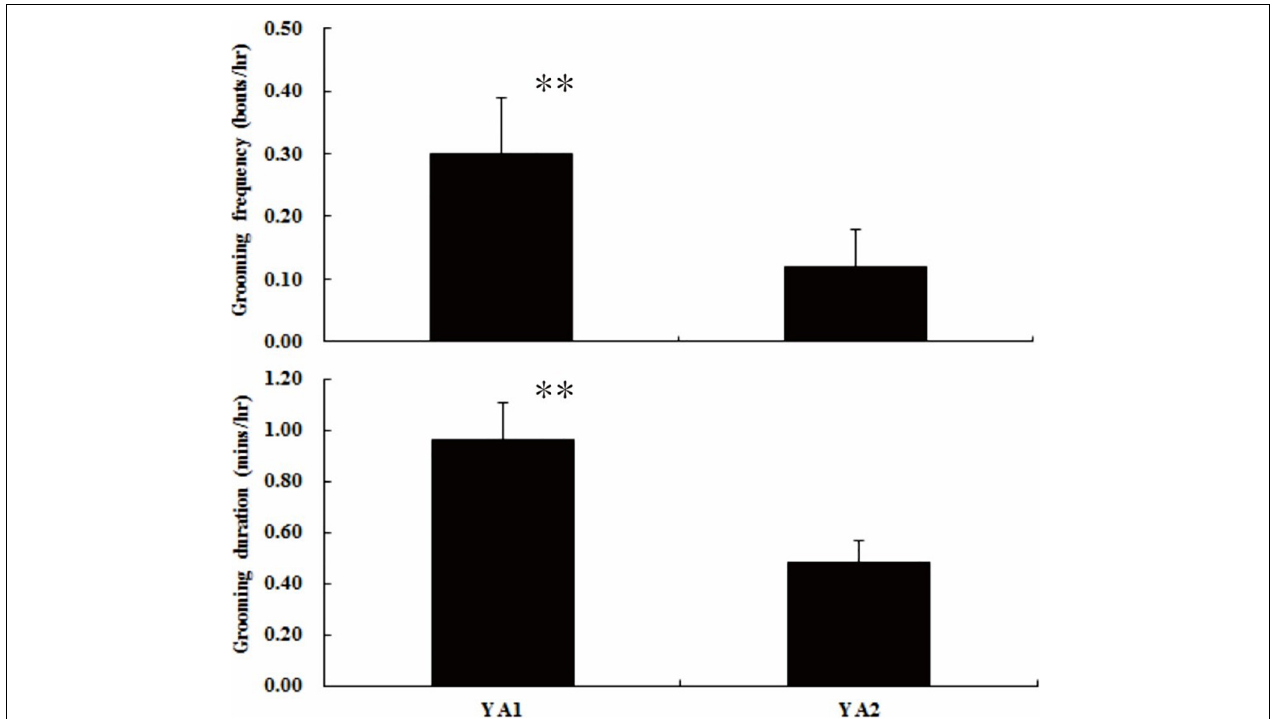
FIGURE 2 | Difference in grooming investment between the YA1 and YA2 groups. ∗∗ P <